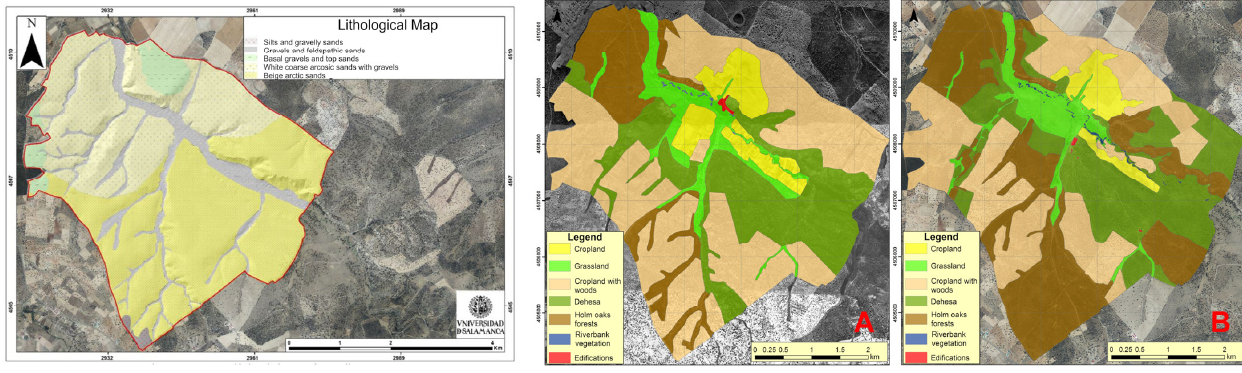
Figure 2. Left . Geological Map. Right : Changes in land use observed in the study area: 1956 ( A ) and 2020 ( B ) based on SIOSE (https://www.siose.es/) (accessed 20 October 2021) .